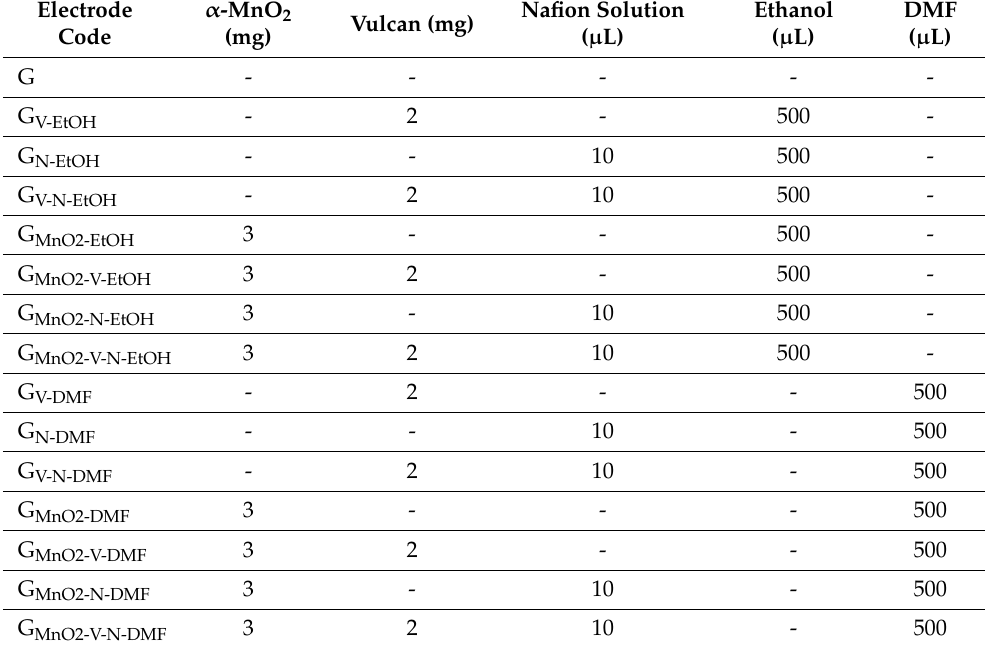
Table 2. The codes used to identify the bare electrode and each modified electrode, with the composi- tions of the suspensions employed in the modification